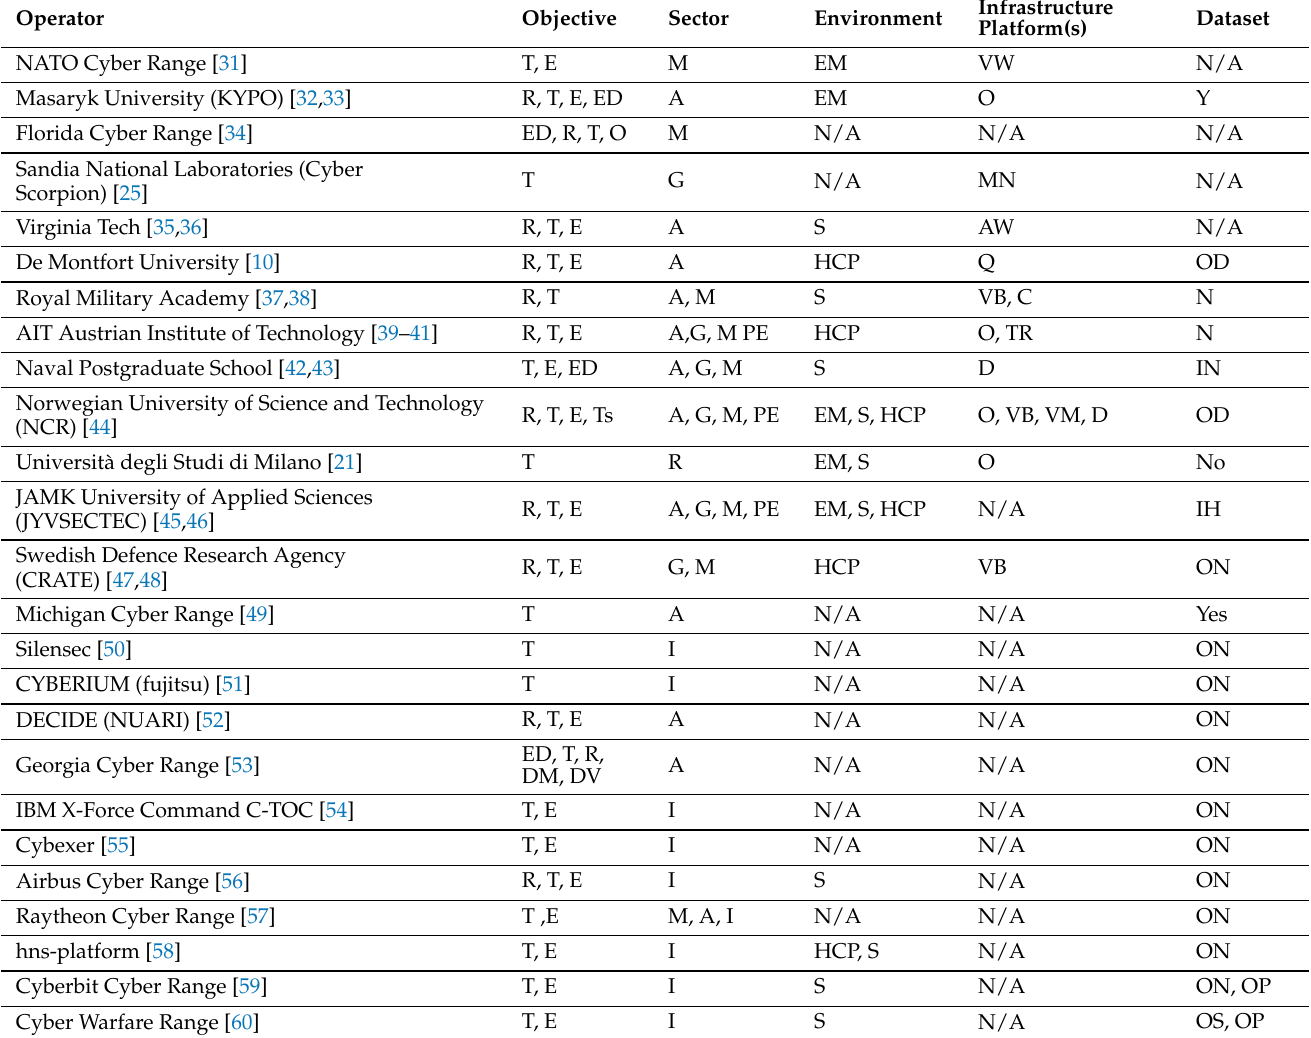
Table 2. Summary of cyber ranges and